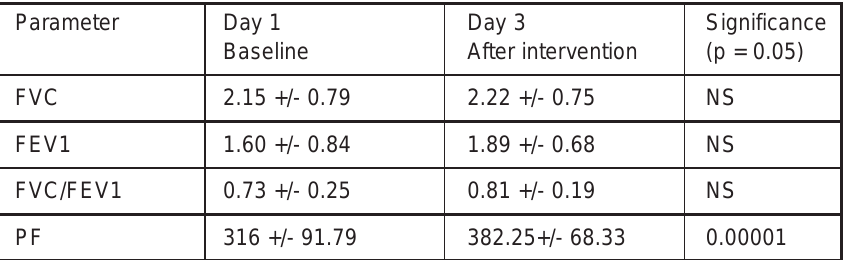
Table 4: Changes in the ventilometric measurement in the experimental group over the 3 day period of